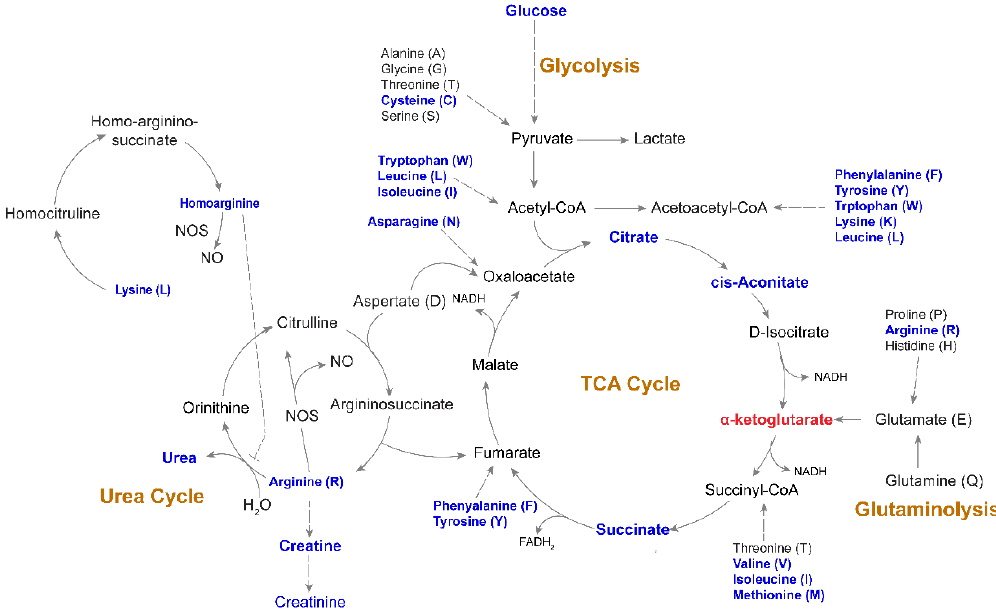
Figure 8. Altered metabolic pathways associated with HIV-1 infection following long-term therapy Schematic map of tricarboxylic acid (TCA) cycle, glycolysis, urea cycle, and glutaminolysis. Blue indicates a significantly ( p < 0.05) lower level of metabolites in PLHIV compared to HC. α-ketoglutarate was the only metabolite that had a significantly higher level (marked in red) in PLHIV compared to HC. 2.7. Changes in Phospholipids, Ceramides, and Other Complex